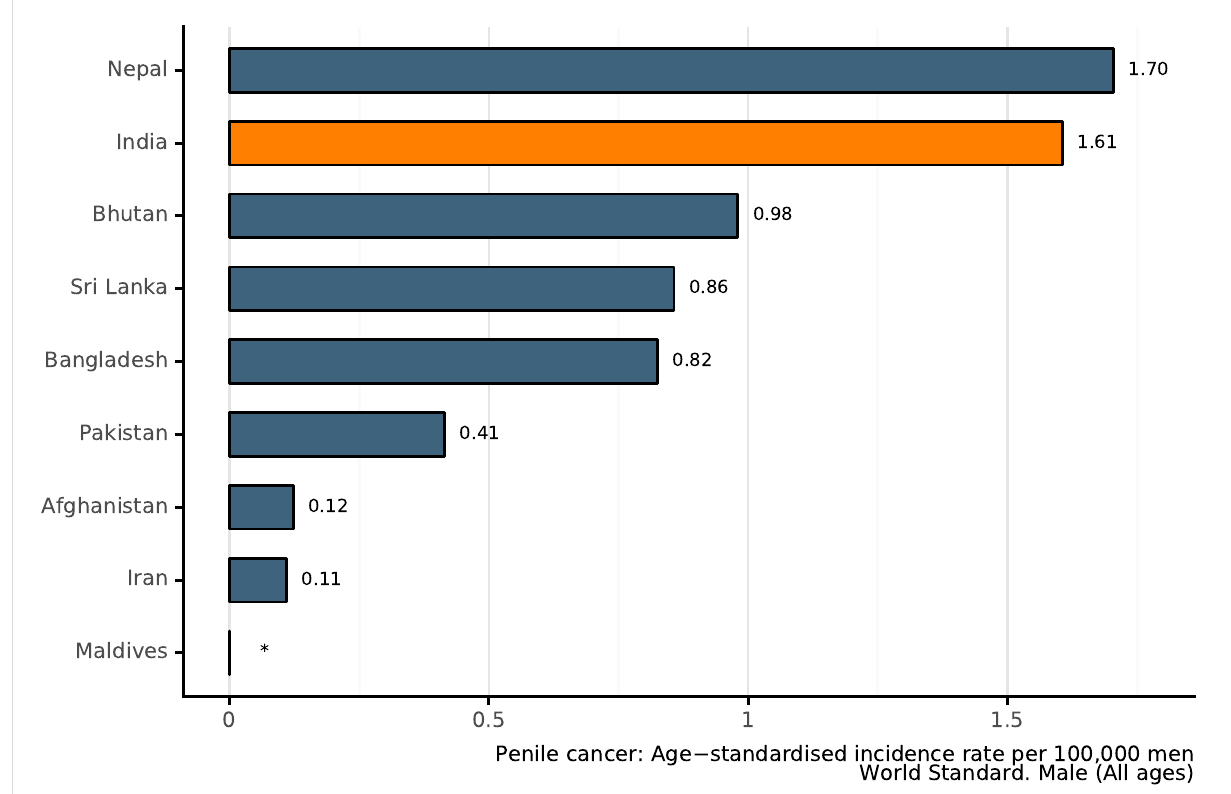
Penile cancer: Age standardised incidence rate per 100,000 men World Standard. Male